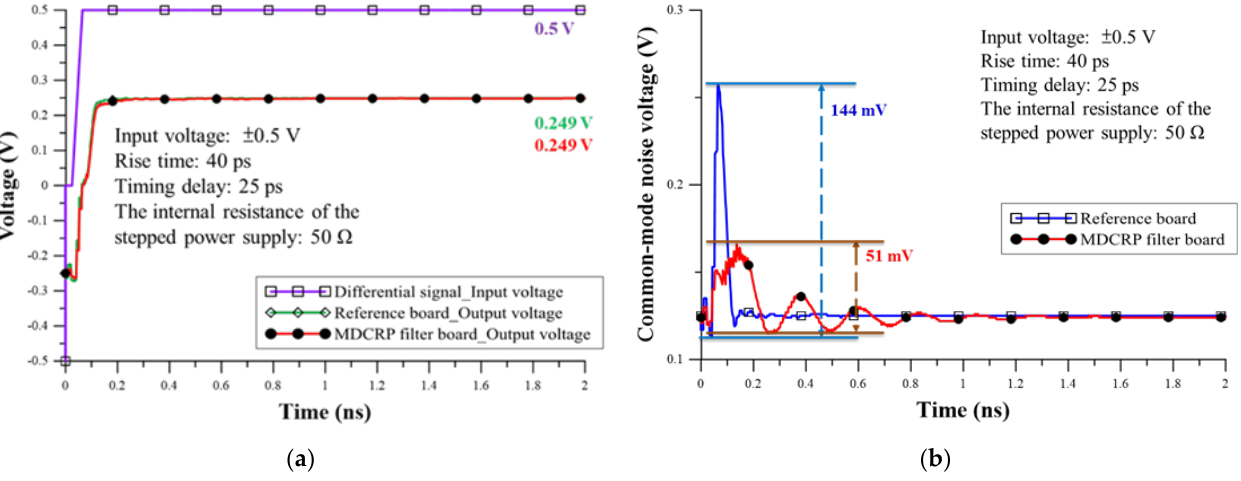
Figure 9. Comparison of the measured results between the MDCRP structure filter board and the reference board. ( a ) Output voltage of the differential signal. ( b ) Output voltage of CM noise.